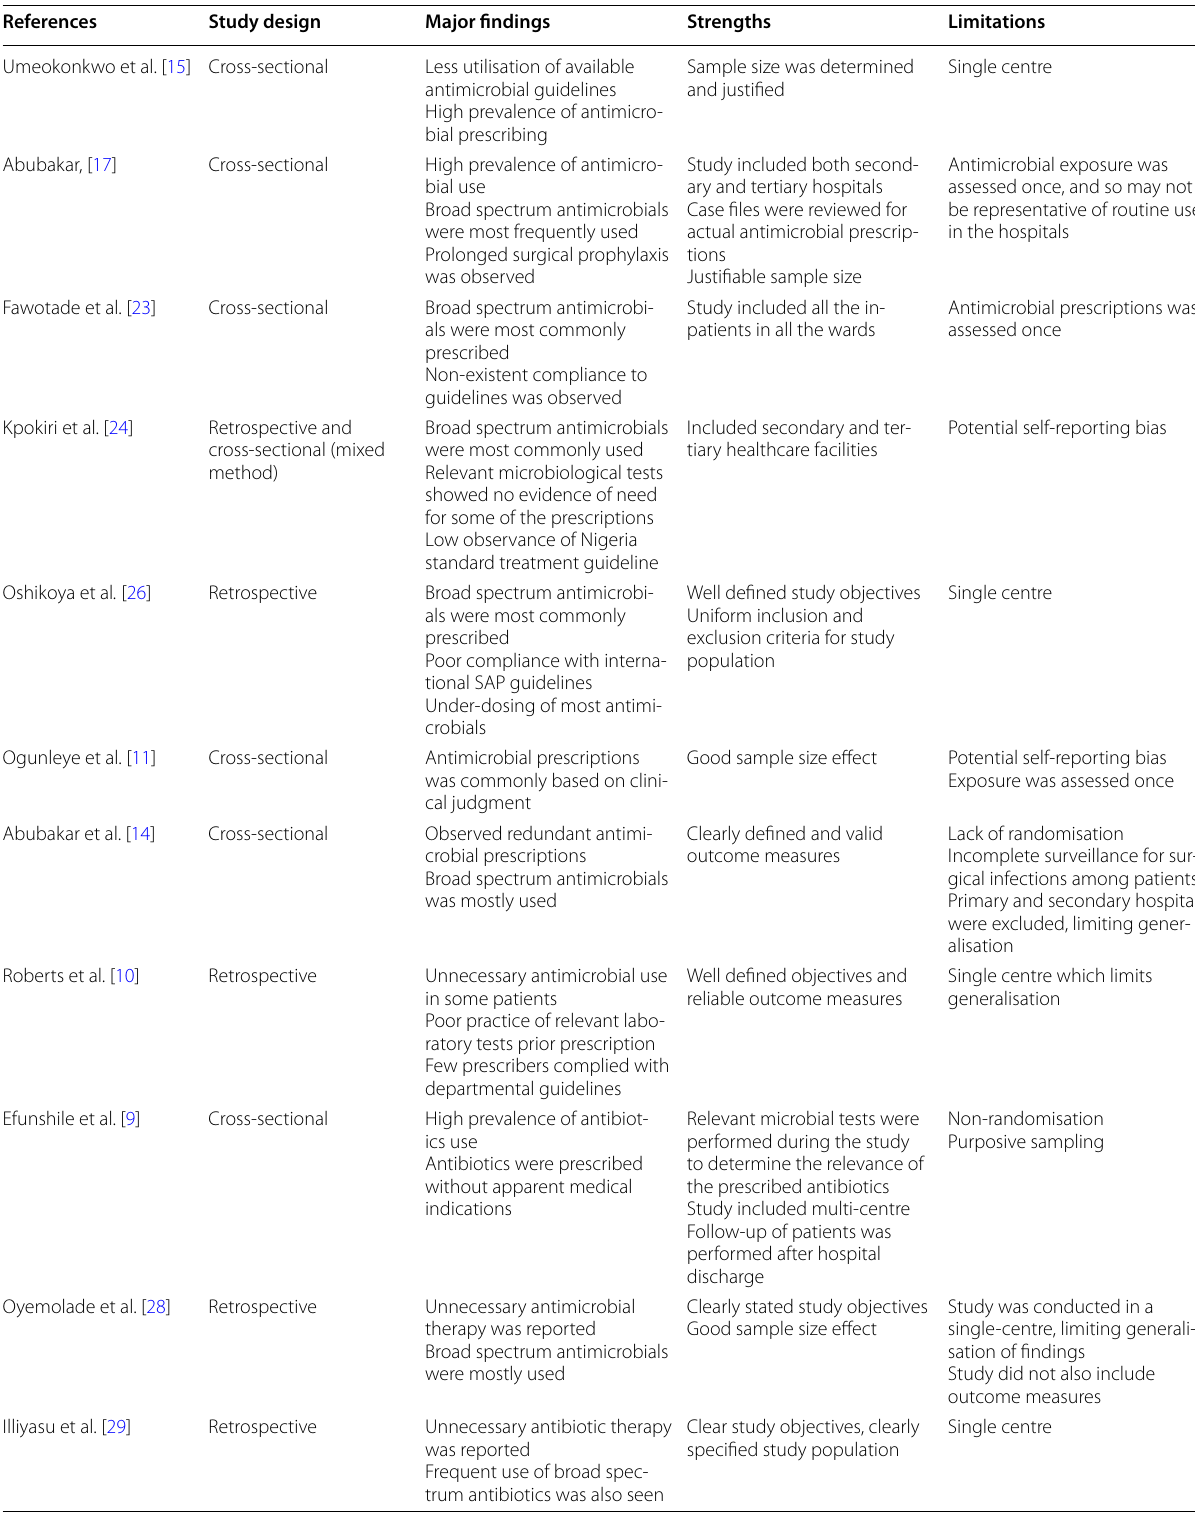
Table 1 Characteristics of studies on in-patients’ antimicrobial